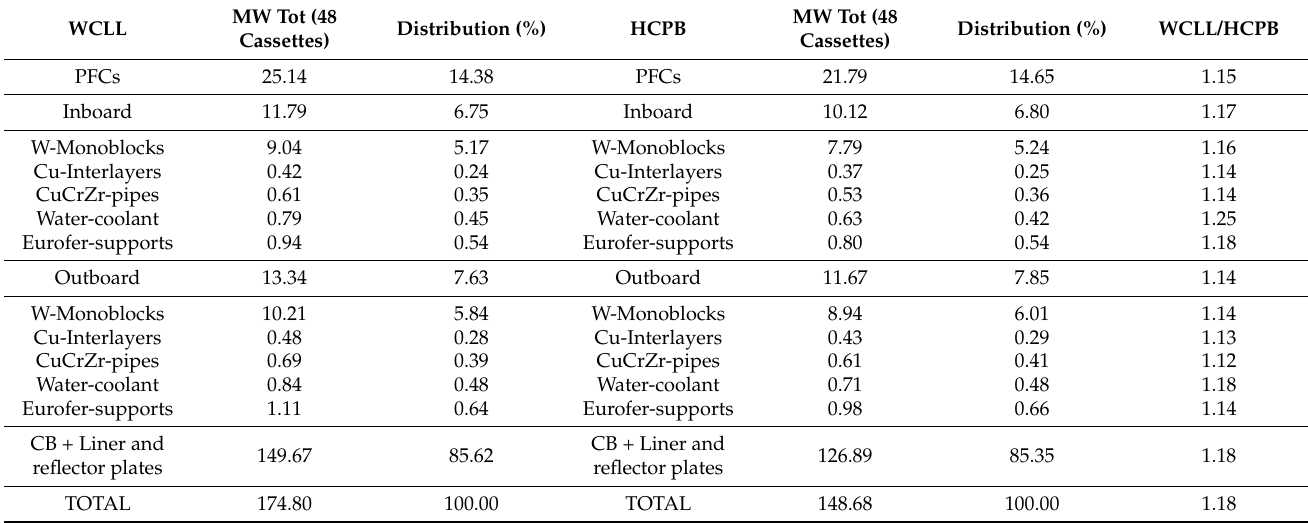
Table 10. Comparison between the total nuclear power (MW) deposited on the DEMO divertor (showing the breakdown for each single contribution) both for WCLL and HCPB blanket, considering all the 48 divertor cassettes.